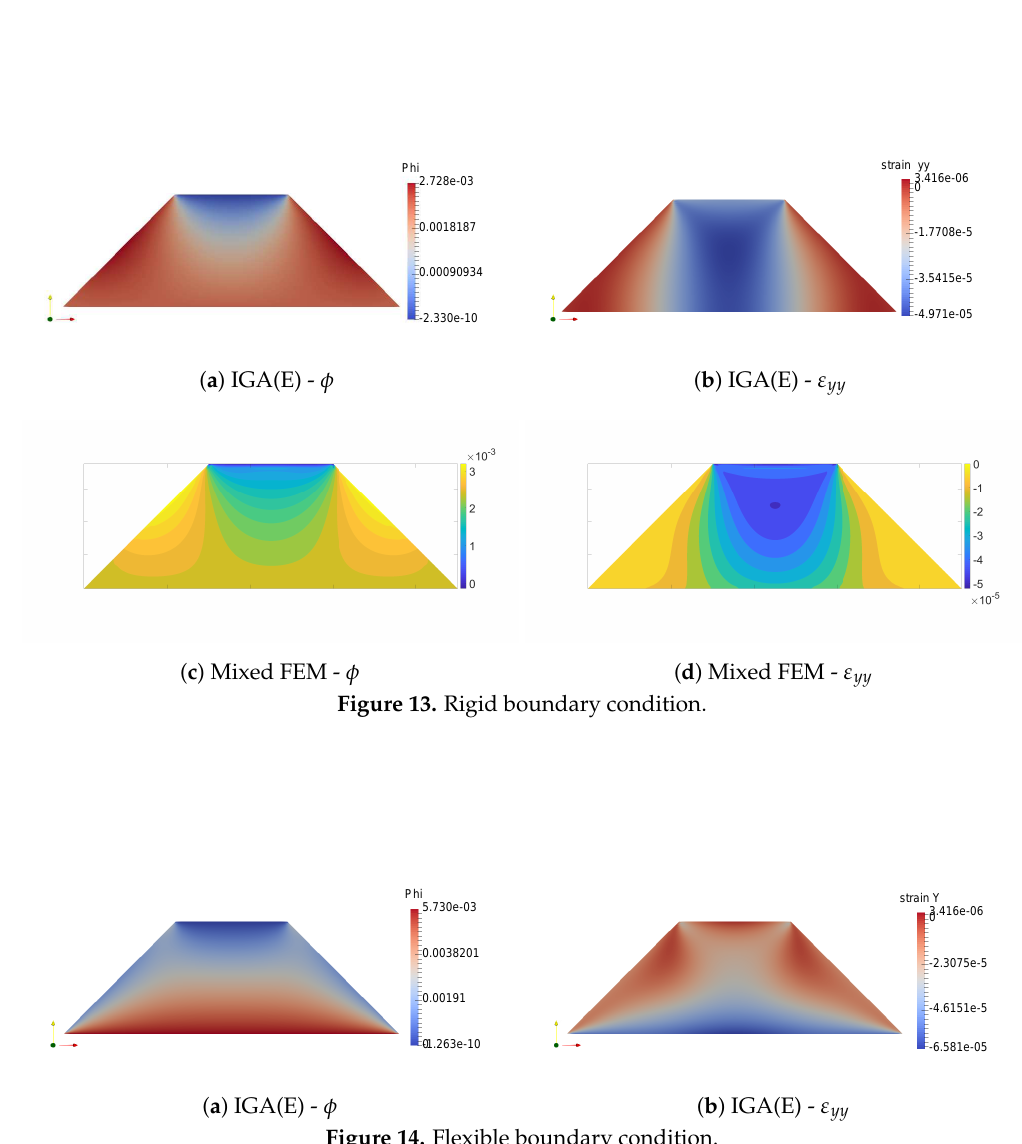
Figure 14. Flexible boundary